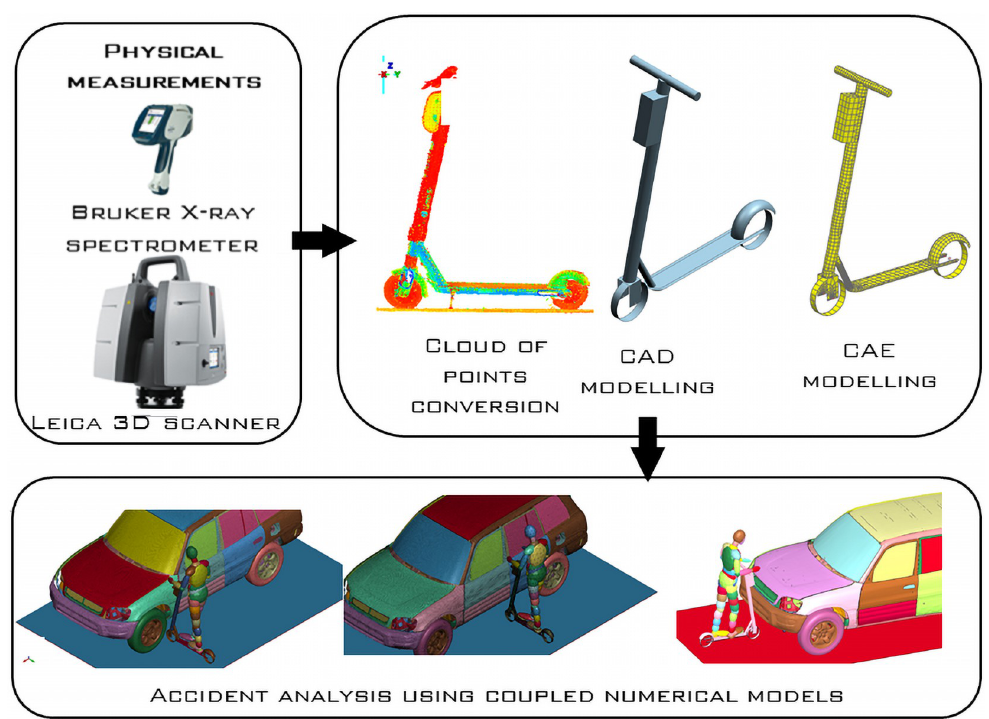
Fig 3. The approach used for the study was based on reverse engineering and coupled LS-DYNA with MADYMO codes.